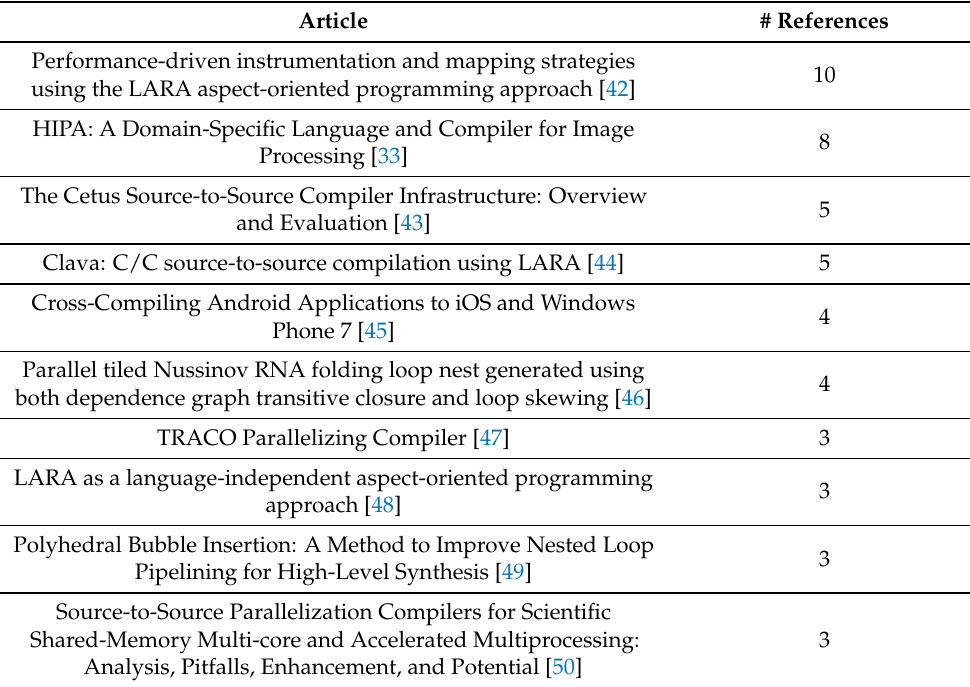
Table 7. Top 10 most-referenced among the selected